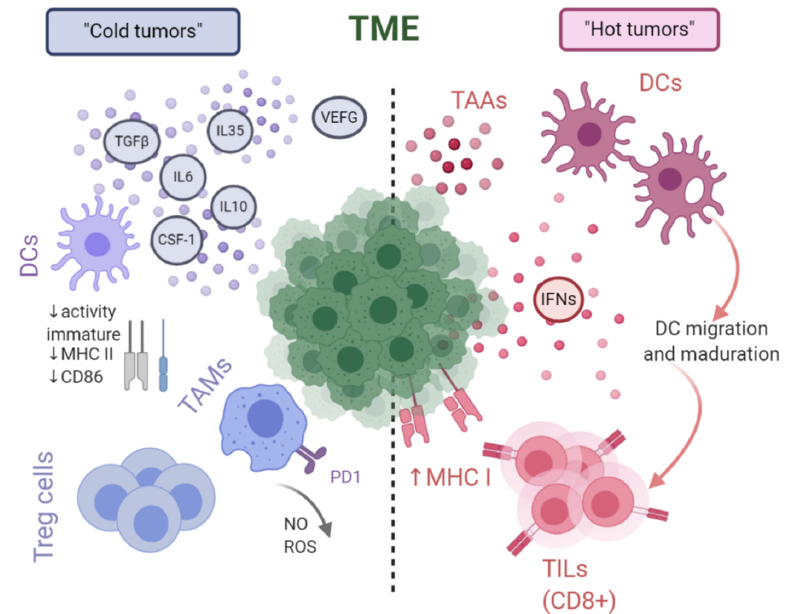
Figure 2. Main cells and signaling components involved in tumor microenvironment (TME) that confers lack (“cold” tumors) or enhancement (“hot” tumors) of immunogenicity to cancer cells. Immunotherapy and novel chemotherapy base their successes on the immunogenic- ity of tumors [11]. On the one hand, it is necessary to increase the recruitment of T cells in